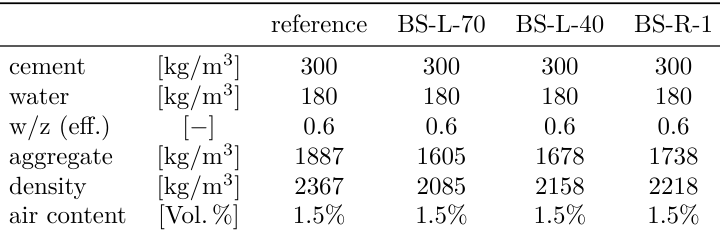
Table 3. Concrete mix and properties of fresh concrete mixtures.